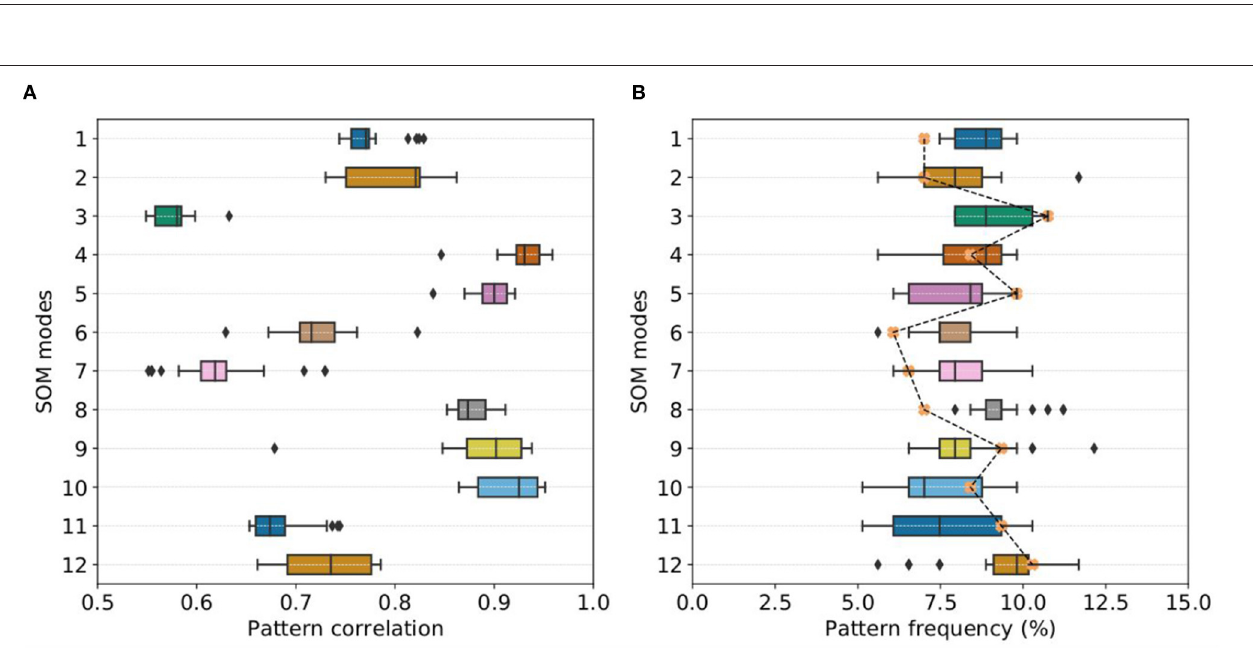
FIGURE 3 | Model agreement with reanalysis: (A) Pattern correlation between observed and simulated SOM modes (per ensemble member). (B) Associated frequency of observed and simulated SOM modes (per ensemble member). X markers and dashed lines represent observed